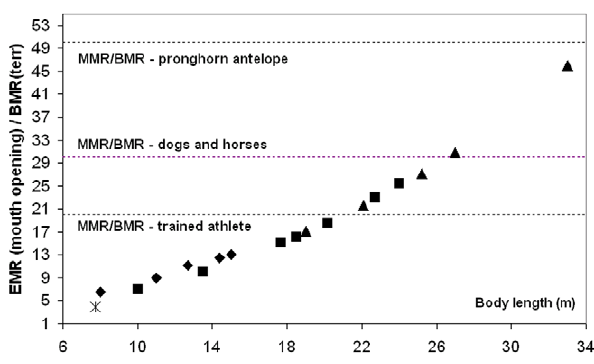
Figure 10. Mouth opening EMR as compared to RAAMR. Ratios calculated for fin (squares) and blue whales (triangles). The 33m blue whale is non-extant. doi:10.1371/journal.pone.0044854.g010 PLOS ONE |